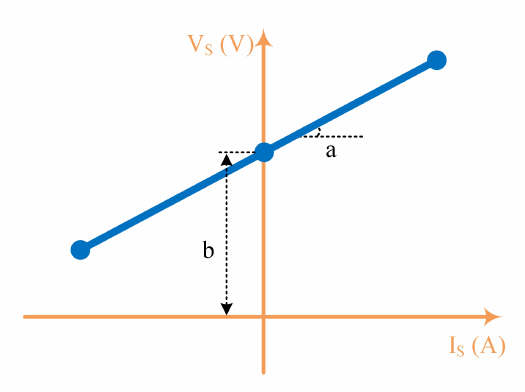
Figure 10. Sensor output transfer